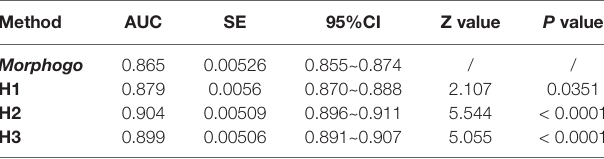
TABLE 2 | Comparison of diagnostic values of Morphogo (classi fi cation threshold = 0.426) and pathologists H1, H2 and H3.